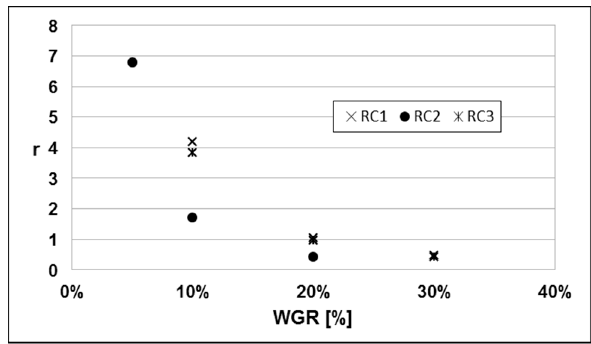
Figure 15. Momentum ratio between air and recirculated gases at inlet sections.